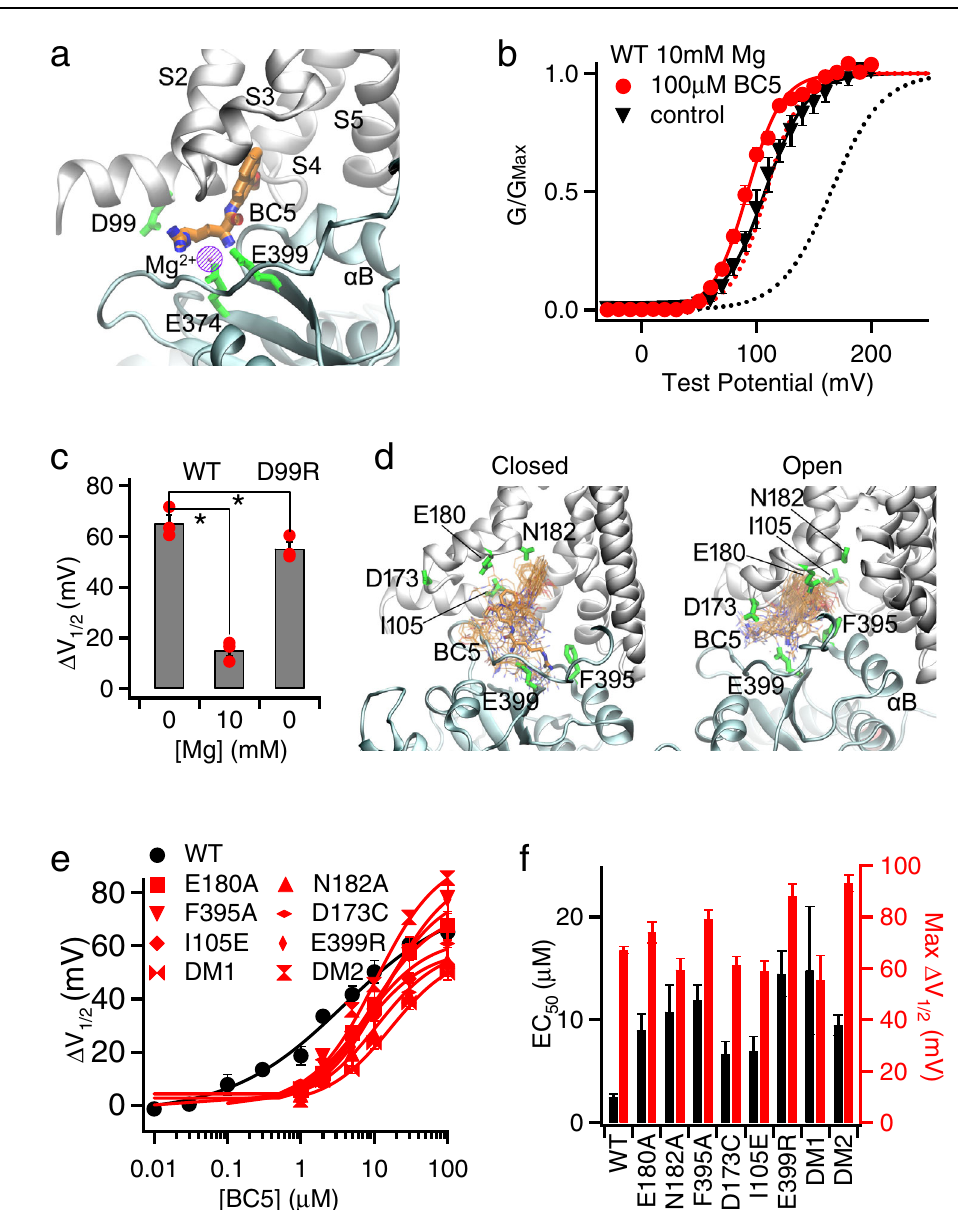
Fig. 2 | BC5 interactions with the targeted site at the CTD-VSD interface. a The cryo-EMstructureof hSlo1 (PDB:6v38)withBC5dockedtoitstargetedsite.Asimilar region as in Fig. 1a is shown. The VSD and CTD are colored silver and cyan, respectively. Mg 2+ -binding residues (D99, E374, E399) are represented as green sticks. The Mg 2+ position is highlighted using the purple circle, which is hatched to indicate that Mg 2+ and BC5 do not bind at the same time. b GV relationship of BK channels and Boltzmann fi ts (solid lines) in 10 mM Mg 2+ . n =3 for control and n =4 for100 µ MBC5.Forcomparison,thedashed linesrepresenttheGVrelationshipsof the control(black)and 100 µ MBC5(red)in theabsenceof Mg 2+ ,taken from Fig.1d. c GVshiftscausedby100 µ MBC5.ForWTtheGVshiftsin0( n =3)and10mM( n =3) Mg 2+ are plotted, and for the D99R ( n =4) mutant, GV was measured in 0 Mg 2+ . *: p=0.0002and0.0475respectively,unpairedStudent ’ st-test.Datapointsareshown